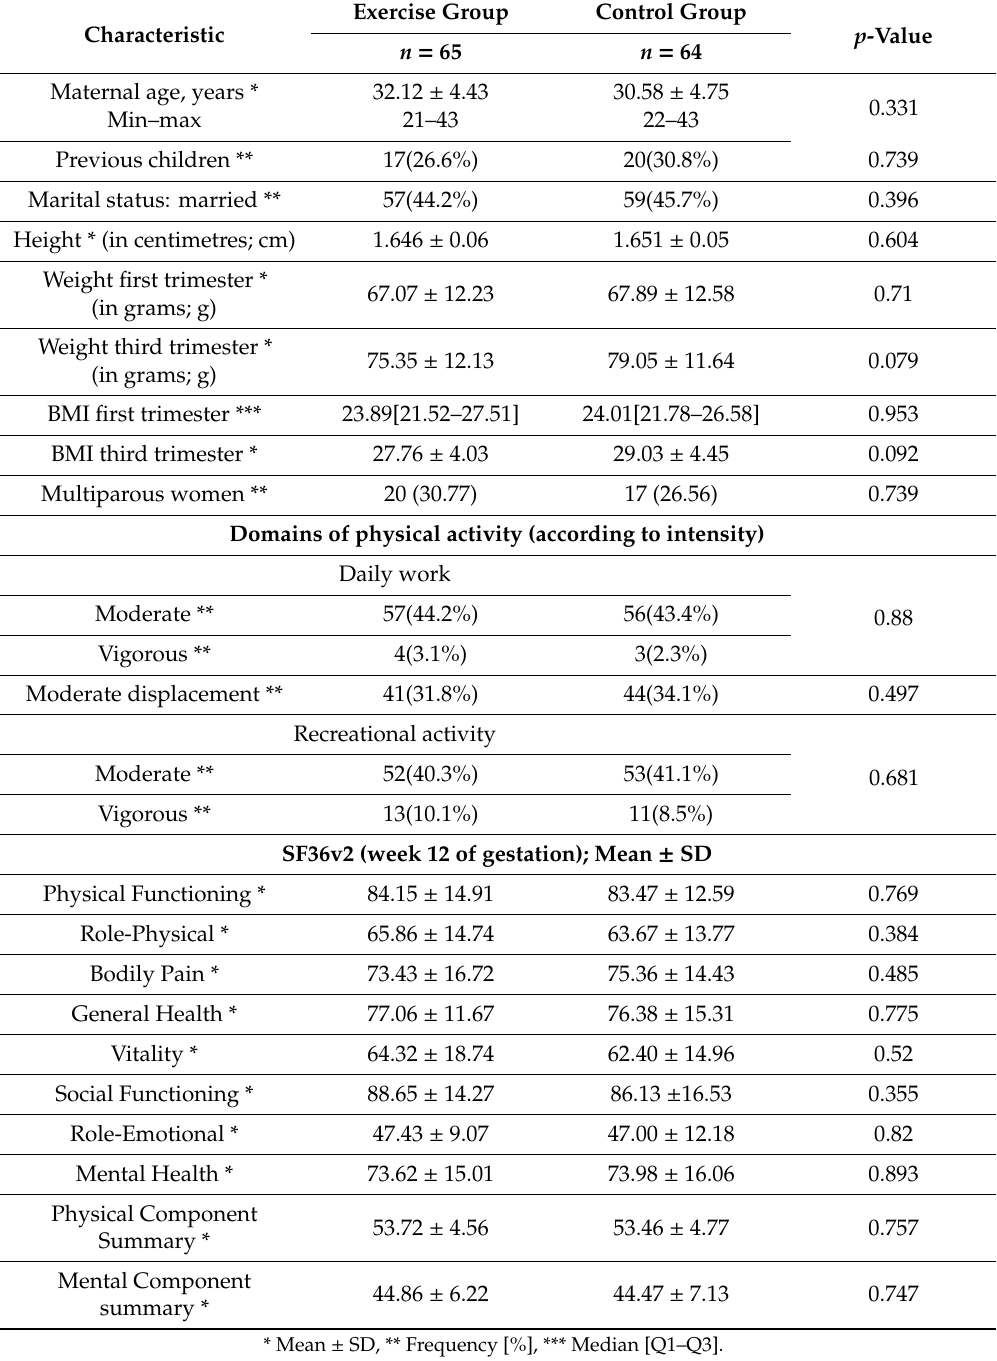
Table 1. Baseline characteristics of the